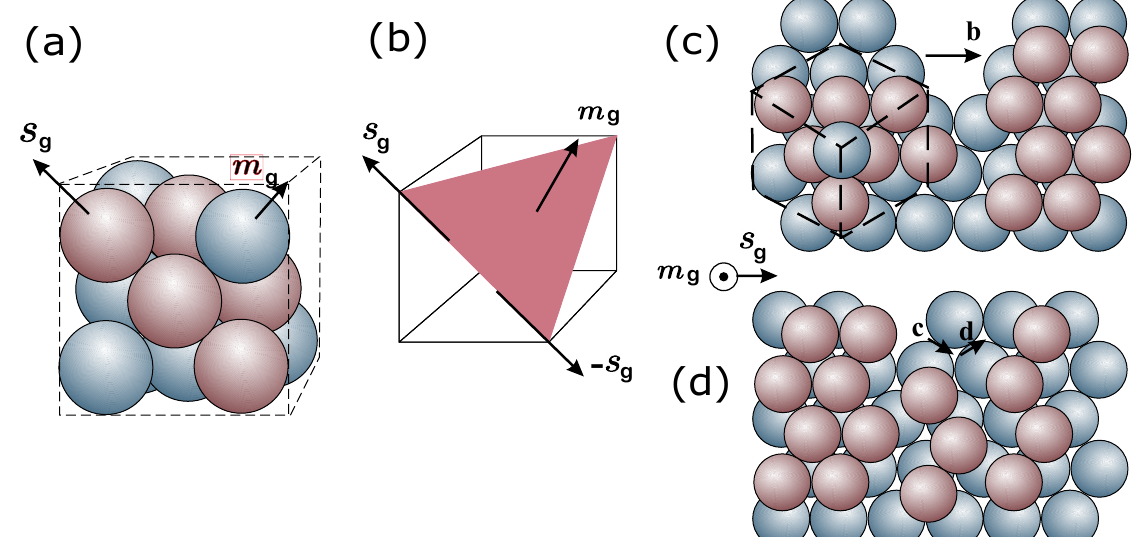
[ ¯110 ] is the Burgers 2 [ ¯12¯1 ] + 1 [ ¯211 ] . Adapted 6 6